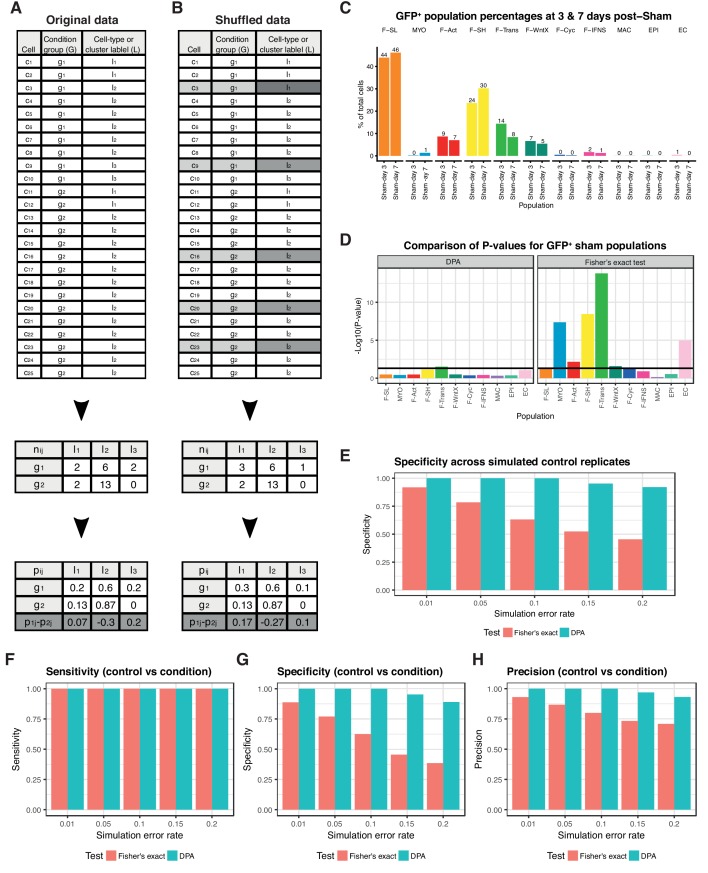
Differential proportion analysis (DPA) procedure and evaluation.(A,B) Procedure for performing DPA. (C) Percentage of cell populations between sham conditions from GFP+ cohort. (D) Comparisons of p-values from Fisher’s exact test and DPA for evaluating proportion changes between sham experiments. (E) Comparisons of specificity for Fisher’s exact test and DPA on control replicate simulation experiment. (F–H) Sensitivity, specificity and precision for simulated control vs condition experiments with comparisons between Fisher’s exact test and DPA.